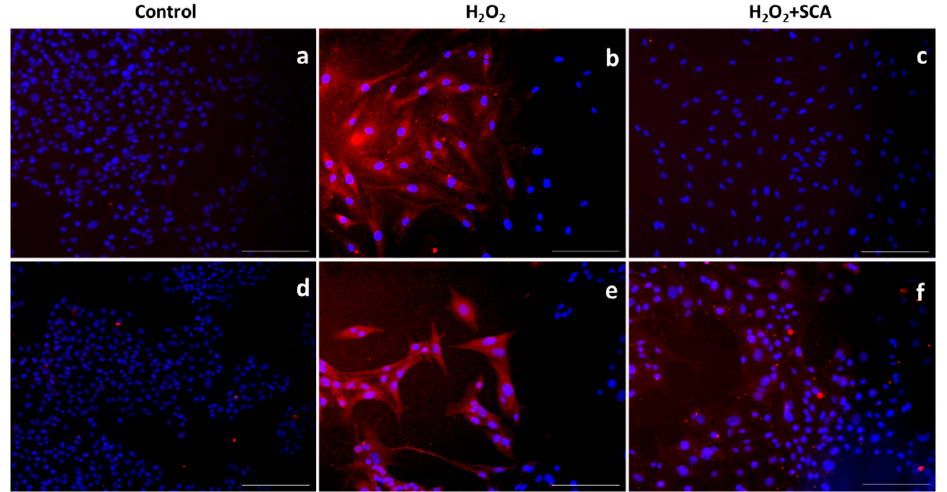
Figure 4. SCA ® treatment markedly inhibited mTOR activation triggered by H 2 O 2 exposure. Im- munostaining of mTOR. Representative inverted fluorescence microscopy images immunostained with anti-mTOR antibody appear in red, while nuclei stained with Hoechst probe appear in blue. Fibroblasts ( a – c ) and B16-F10 cells ( d – f ) exposed to H 2 O 2 ( b , e ) and H 2 O 2 -exposed treated with SCA ® ( c , f ). Scale bars: 200 µm.